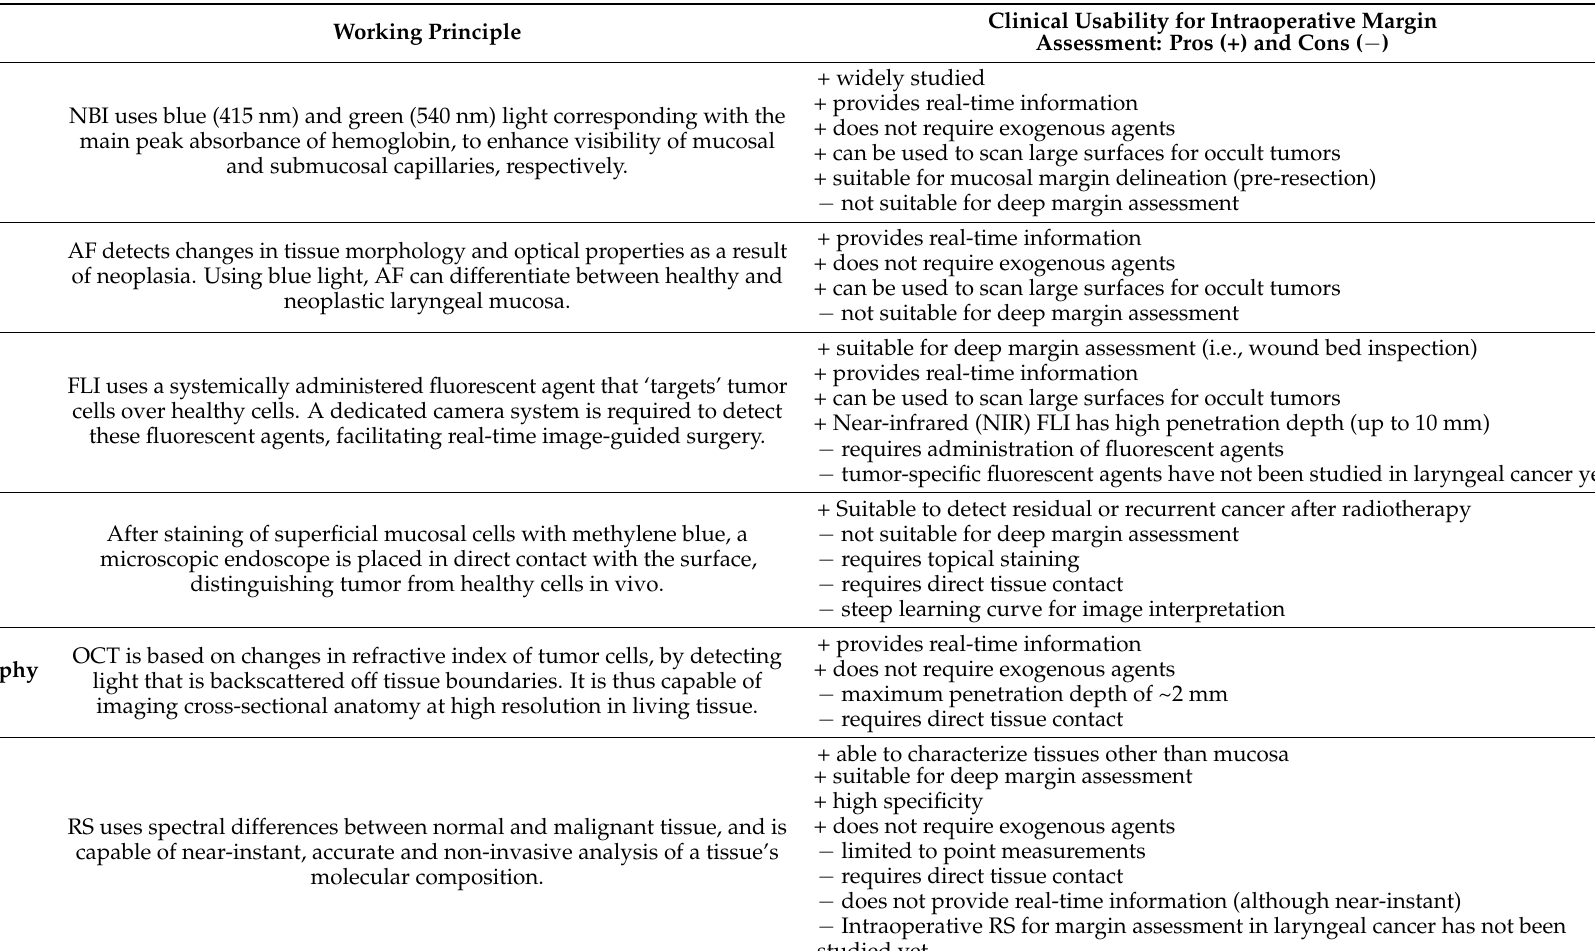
Table 3. Working principles and clinical usability of all imaging techniques for intraoperative margin assessment in laryngeal